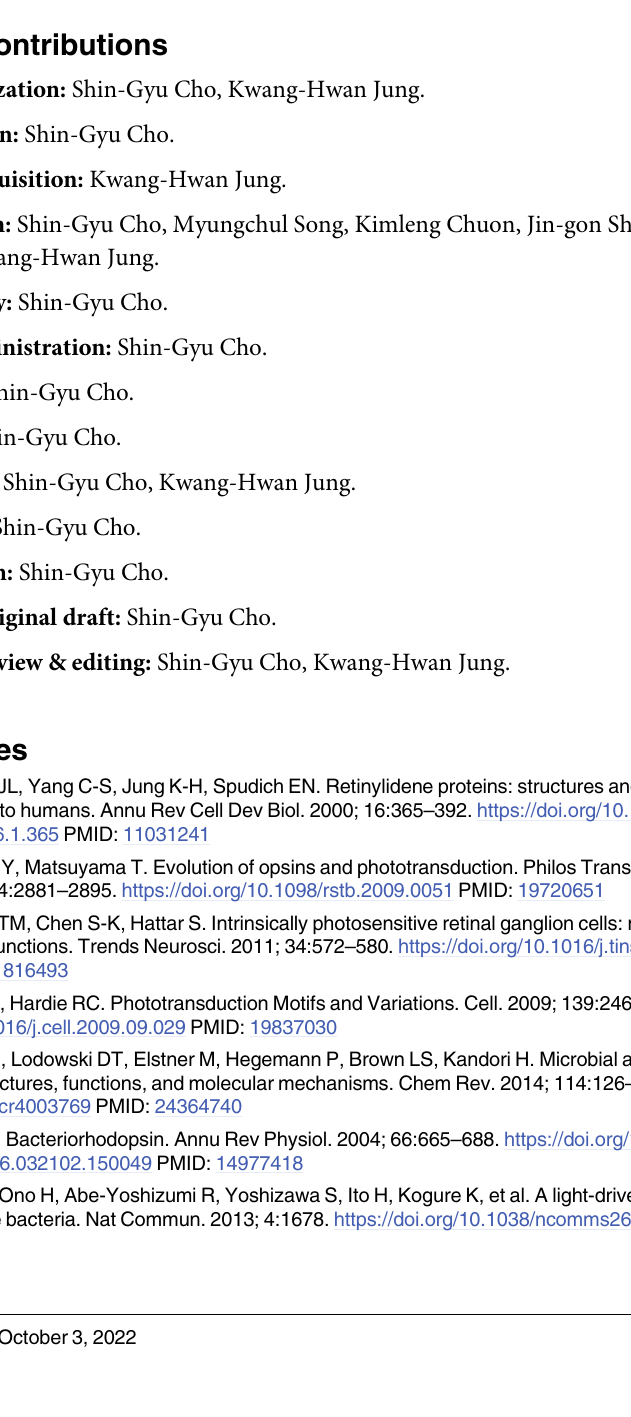
S5 Data. Underlying numerical data of inorganic phosphate standard curve and GS activ- ity using biosynthesis assay. S6 Data. Underlying numerical data of properties of IMVs containing